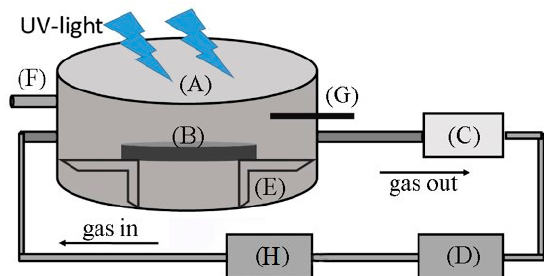
Figure 1. Schematic diagram of the gas-phase photocatalytic test device: ( A ) stainless steel reactor; ( B ) specimen; ( C ) vacuum pump; ( D ) gas chromatograph and computer system; ( E ) sample holder; ( F ) reactant injection pore; ( G ) temperature and humidity sensor; ( H ) H 2 O